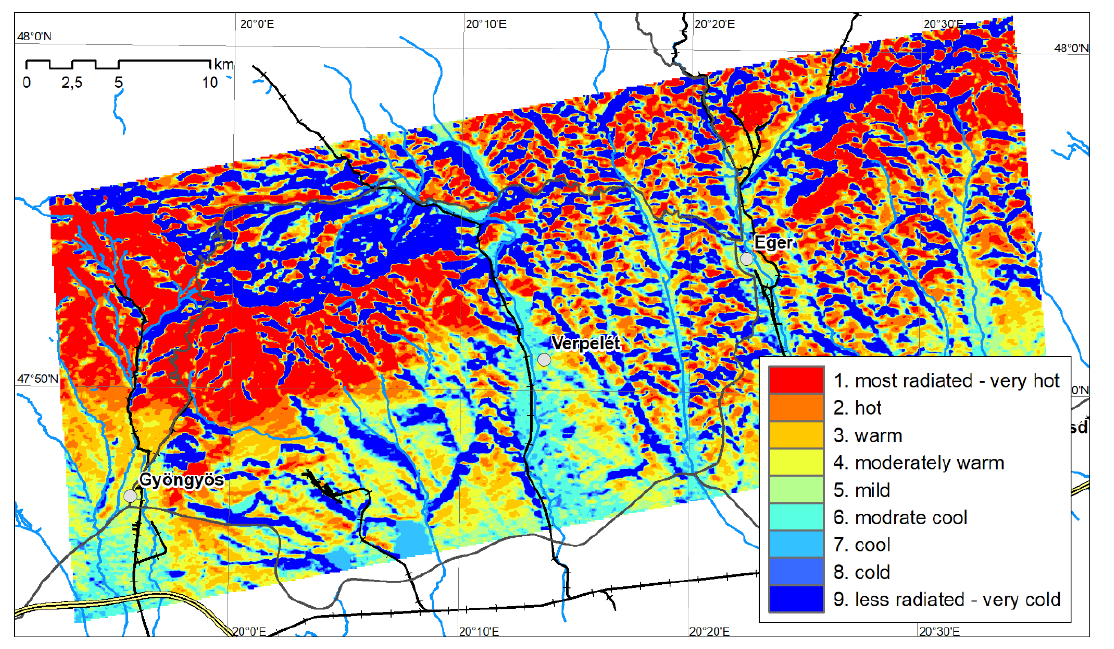
Figure 2. Amount of solar radiation on morpho-pedotops.